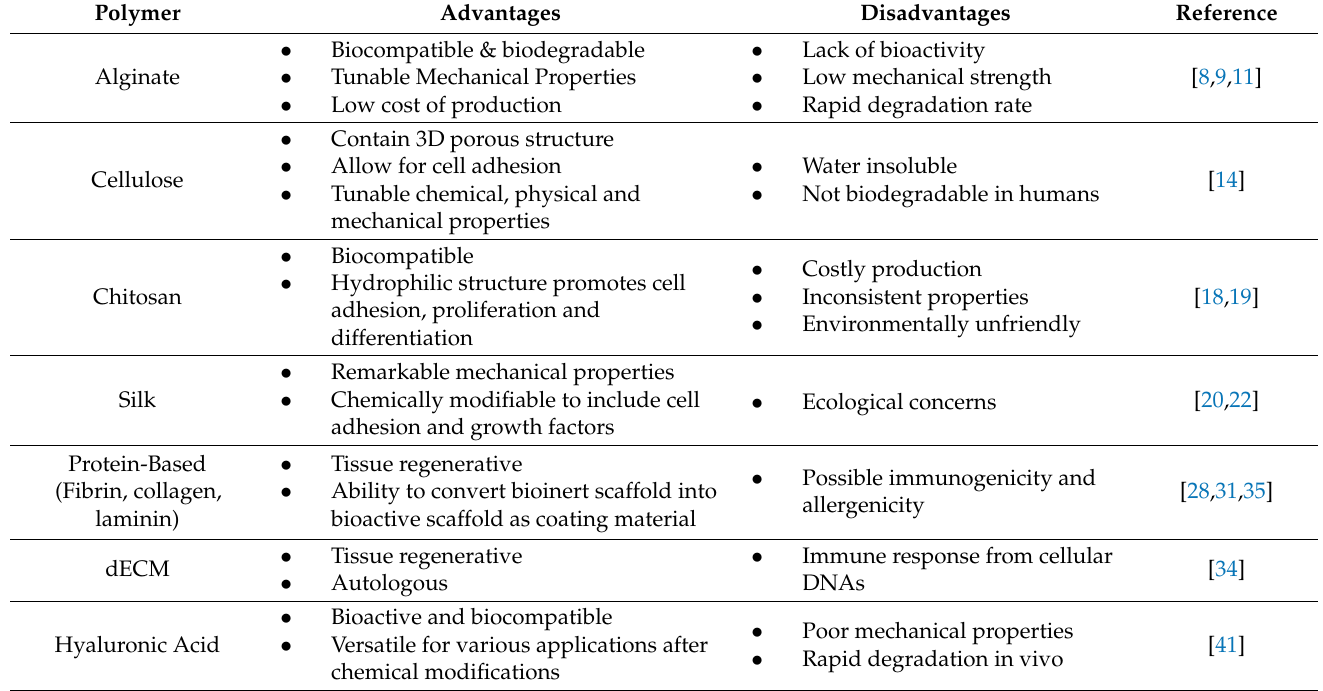
Table 1. Advantages and disadvantages of natural polymers for dental, oral and craniofacial regenerative medicine. Polymer Advantages Disadvantages Reference